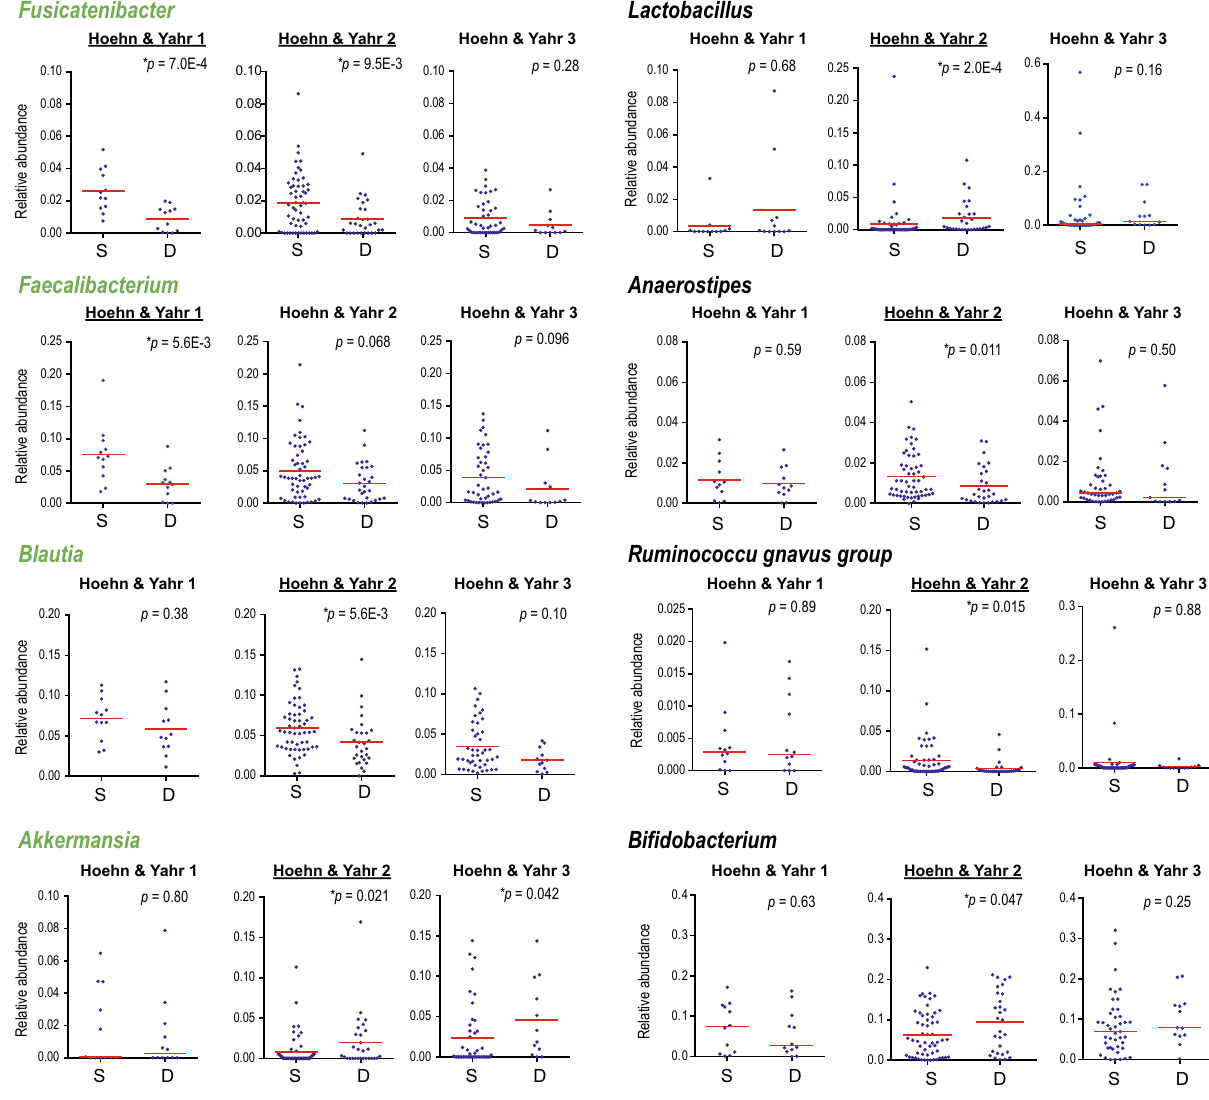
Fig. 3 Relative abundances of essential genera at year 0, which made the maximum AUROCs for HY stages 1 and 2 in Fig. 2eh, in the stable (S) and deteriorated (D) groups. HY stages for which a speci fi c genus was essential in modeling are underlined. Genera that were signi fi cantly changed in our dataset in our previous analysis 38 are indicated in green letters. Note that vertical scales are different for different HY stages in Akkermansia , Lactobacillus , and Ruminococcus gnavus group . Means are indicated by red bars. P -values were calculated by the Wilcoxon rank sum test. * P <